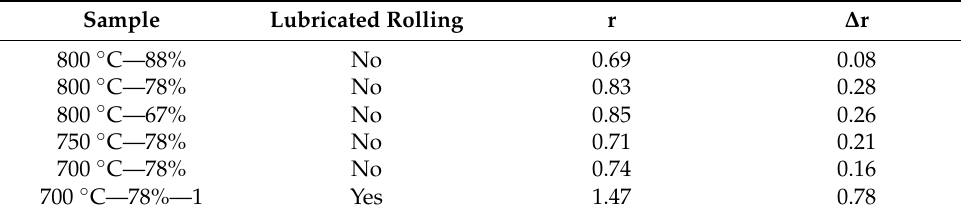
Table 2. Deep drawing properties of the IF steel under different rolling